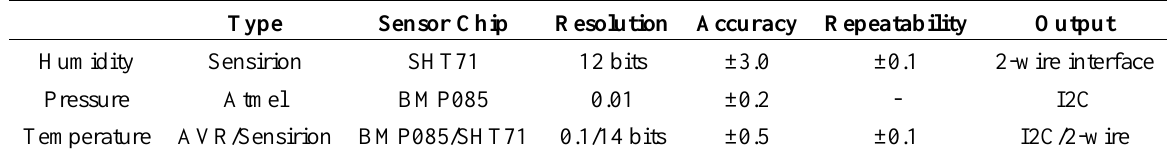
Table 1. Properties of the sensors from the manufacturer datasheet connected to the Raspberry-Pi 1 and Raspberry-Pi 2.